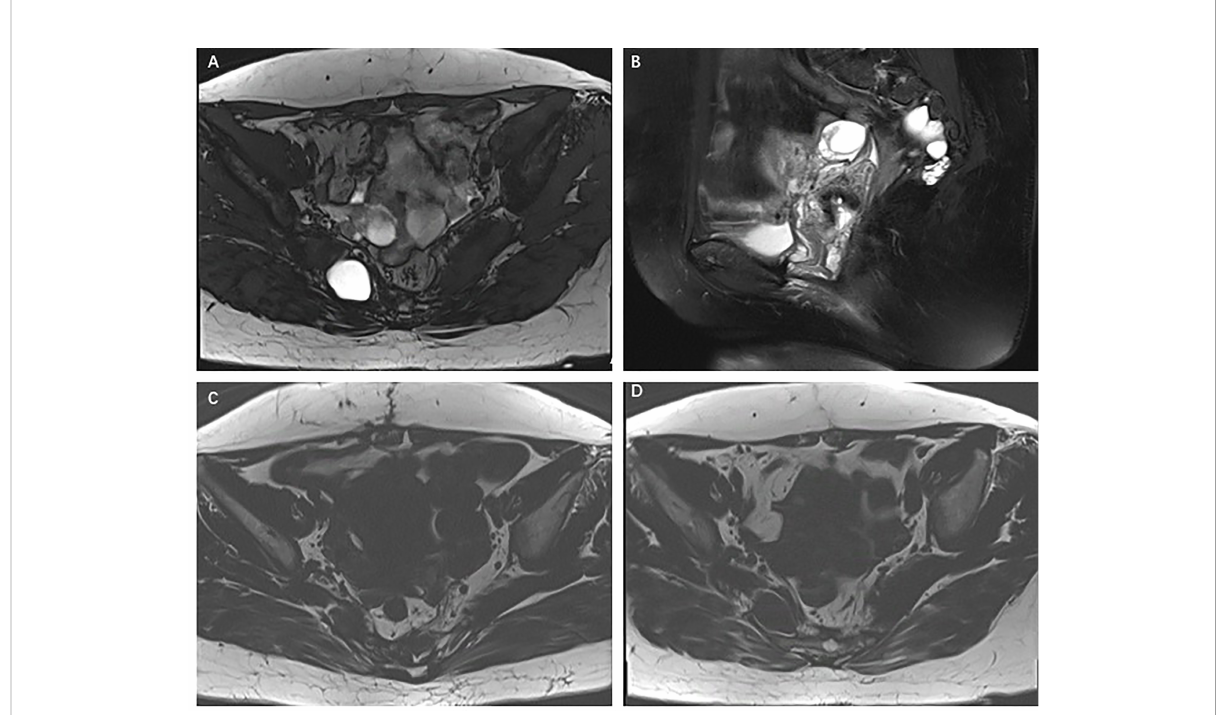
FIGURE 1 (A – C) T1- and T2-weighted MRI scans demonstrating multiple ventricular T2 hypersignal and T1 hypointense cystic lesions in the right buttock tissue and sacrococcygeal region. (D) T2-weighted gadolinium-enhanced MRI scans demonstrating annular enhancement of the cystic wall, but no enhancement of the cystic part of the